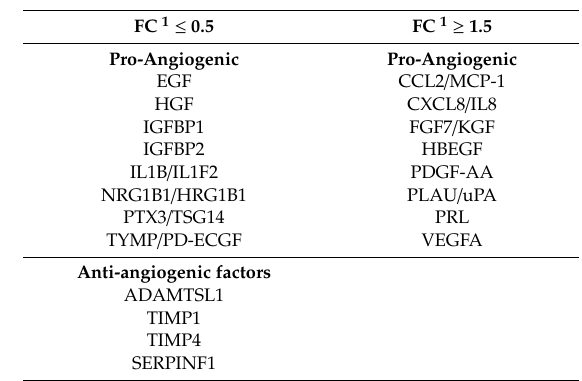
Table 2. Angiogenic genes altered in the context of EPHA2-silencing comparing infected with uninfected siEPHA2_I / siEPHA2_U for fold-changes of ≤ 0.5 and ≥